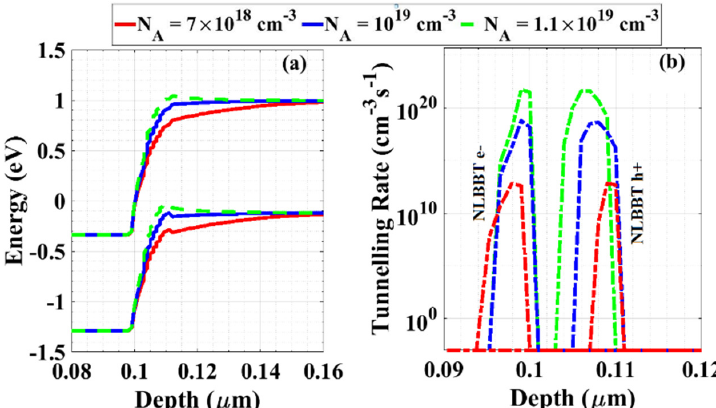
Figure 7. ( a ) Energy band diagram at the interface between the emitter and the RCL to show the band-to-band tunneling at different doping concentrations of RCL, and ( b ) the nonlocal band-to- band electron and hole tunneling rates.